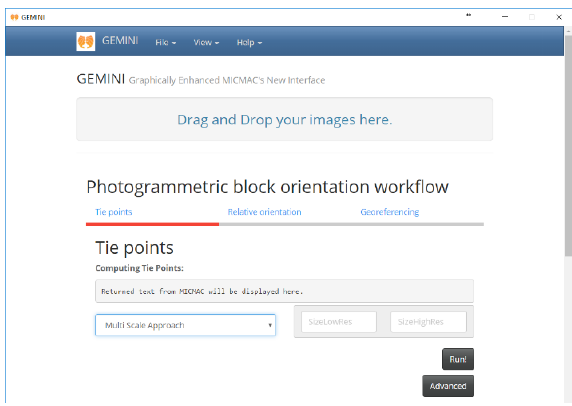
Figure 2. The main page of the GEMINI interface (operating in Windows 10), showing the first part of the photogrammetric block orientation